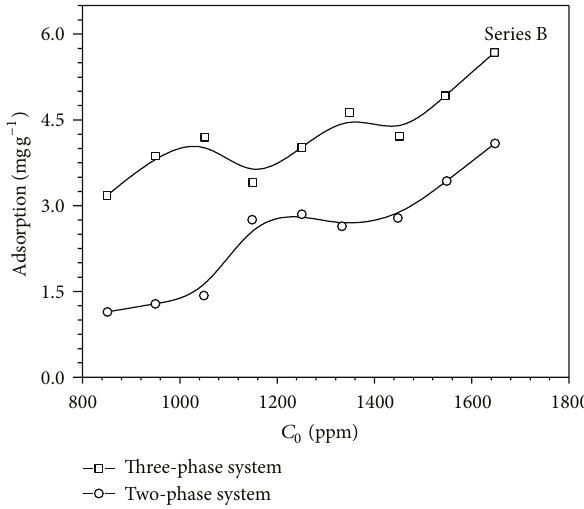
Figure 3: The isothermal adsorption of AP-P4 on the solid phase of two-phase and three-phase systems in the simulative water A.